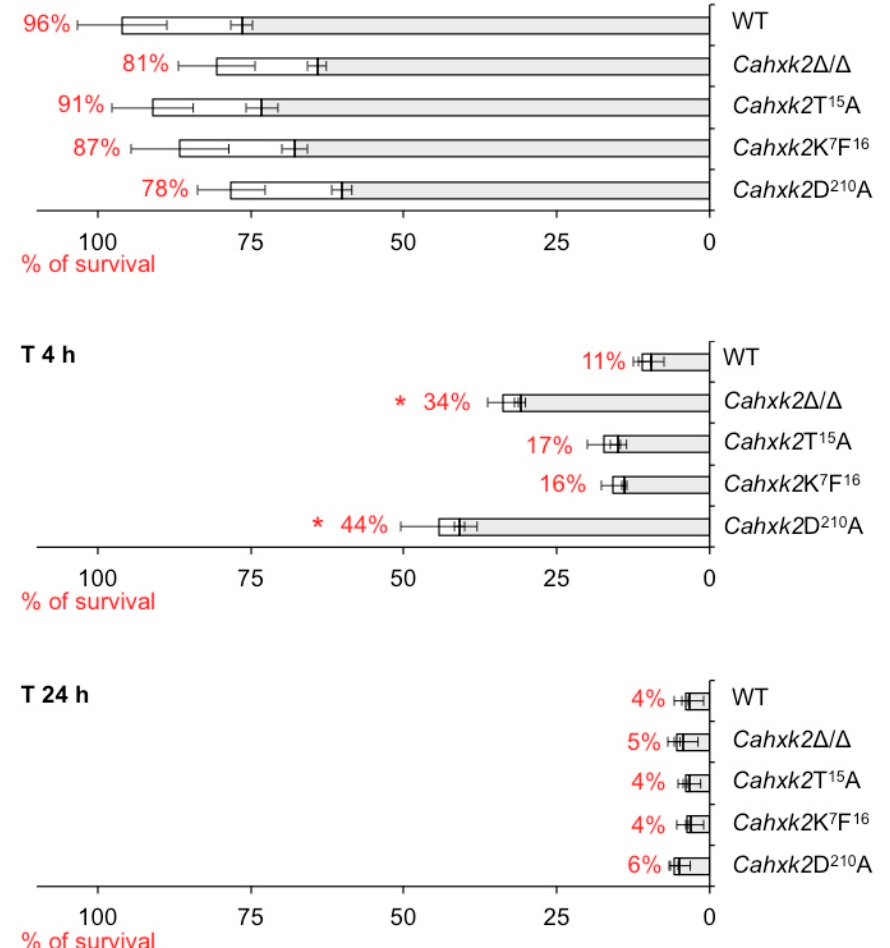
Figure 6. Cahxk2D 210 A mutant is hypo-virulent in a macrophage model. Flow cytometer analysis of mouse macrophage interaction with live C. albicans cells in stationary phase at MOI 1:5 (1 macrophage for five yeasts) over a 24 h time course experiment. The horizontal bars represent the macrophage survival, indicated as a percentage on the left side of the bar. The white part of the bars represents the percentage of non-phagocytosing macrophages. The shaded part represents the percentage of phagocytosing macrophages. Histograms represent a mean of three independent experiments performed on two different biological samples, repeated five times (+ standard error). Unpaired T-test was used to establish statistical significance. * p < 0.005 .